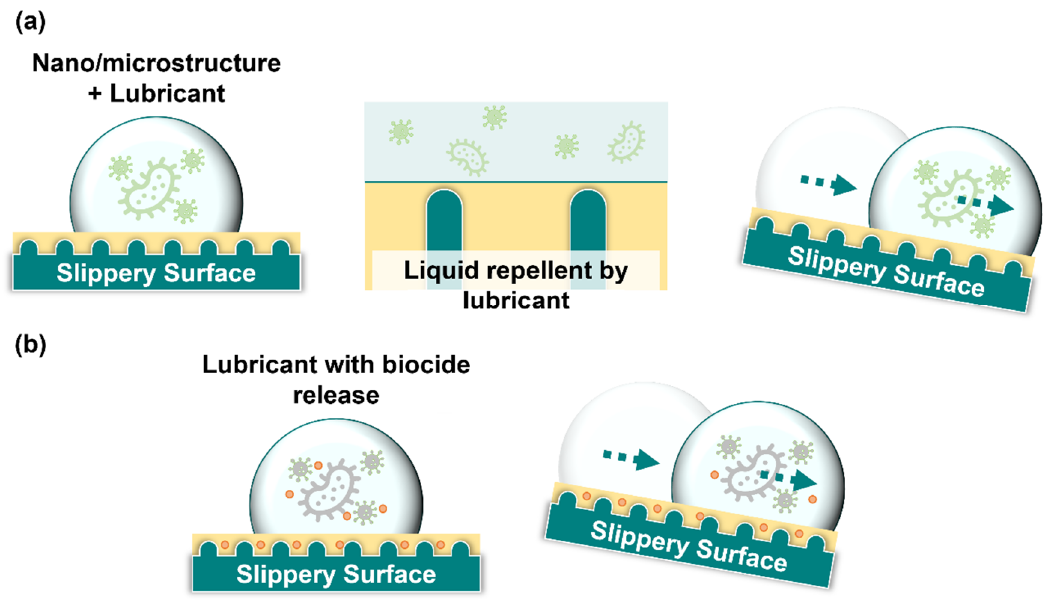
Figure 5. Antimicrobial mechanisms of slippery surfaces. ( a ) The anchored lubricant layer forms a slippery surface that prevents microbes from contacting and colonizing surfaces, hence preventing microbial adhesion. ( b ) A slippery surface can be preloaded with biocides on the structure substrate or in the lubricant to kill microbes. The green arrows indicate the direction of droplet movement on the slippery surface.